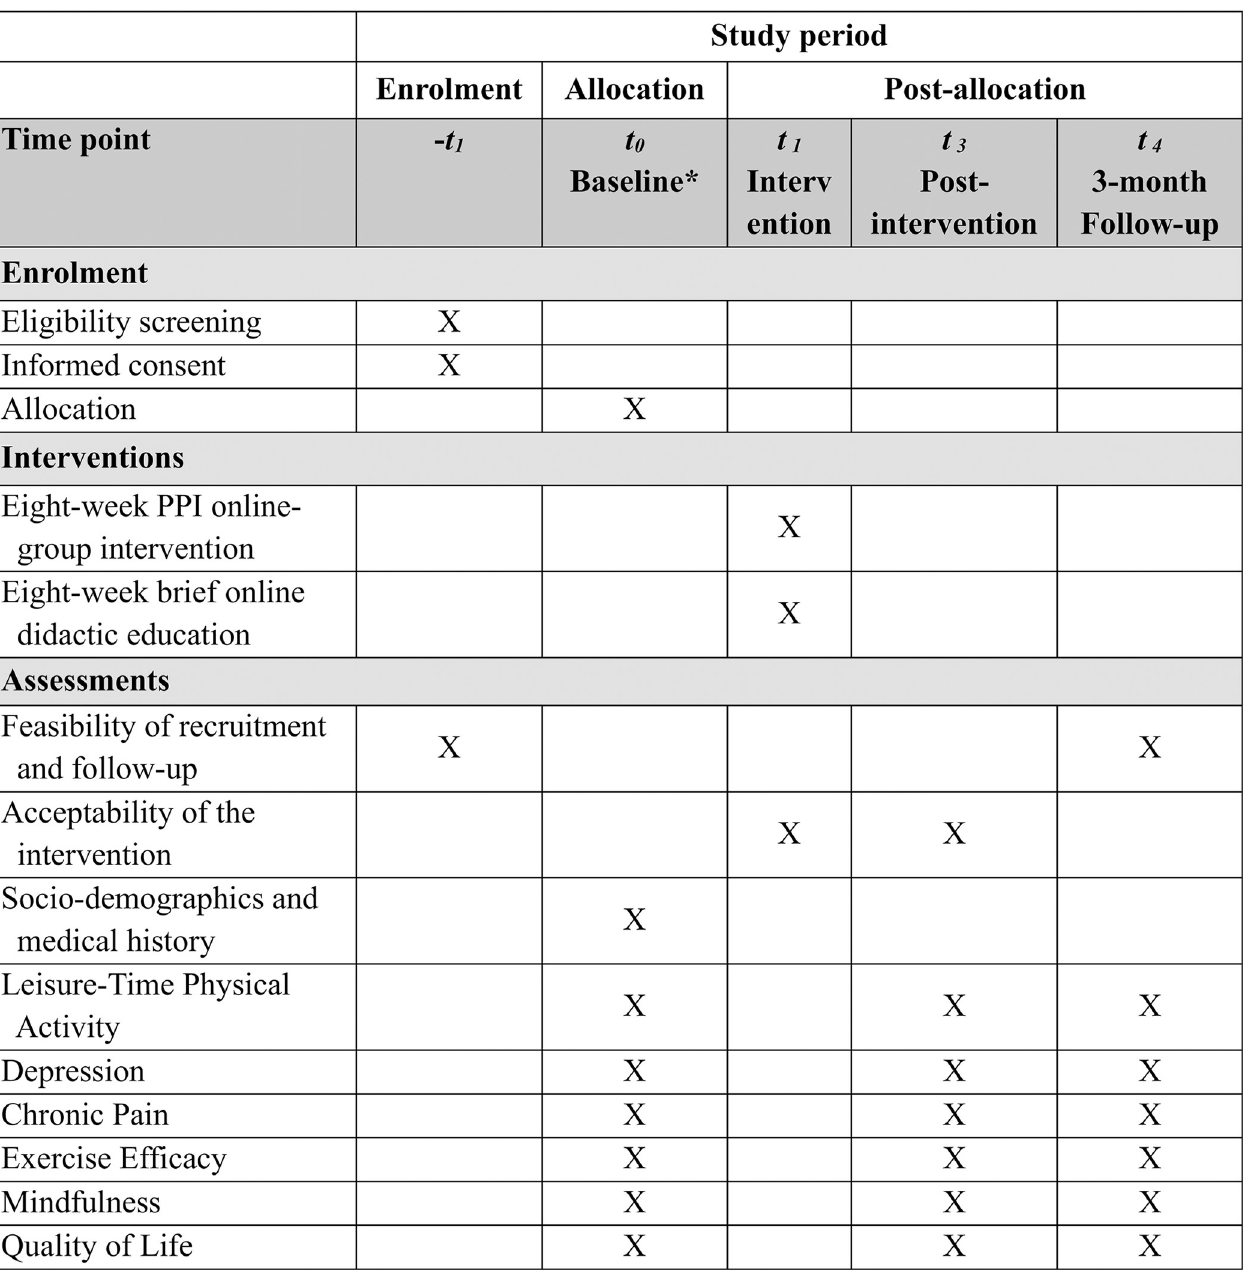
Fig 1. SPIRIT schedule of enrollment, interventions, and